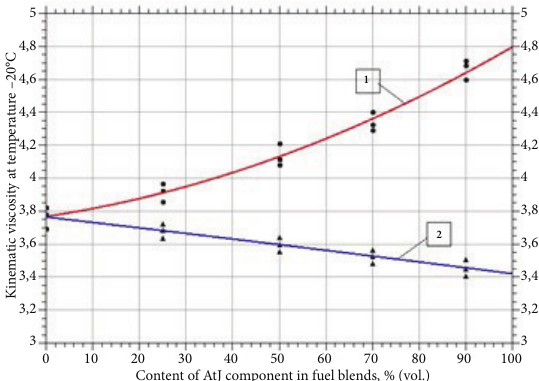
Figure 4. Dependence of the viscosity of JF blends on the content of AtJ components produced from